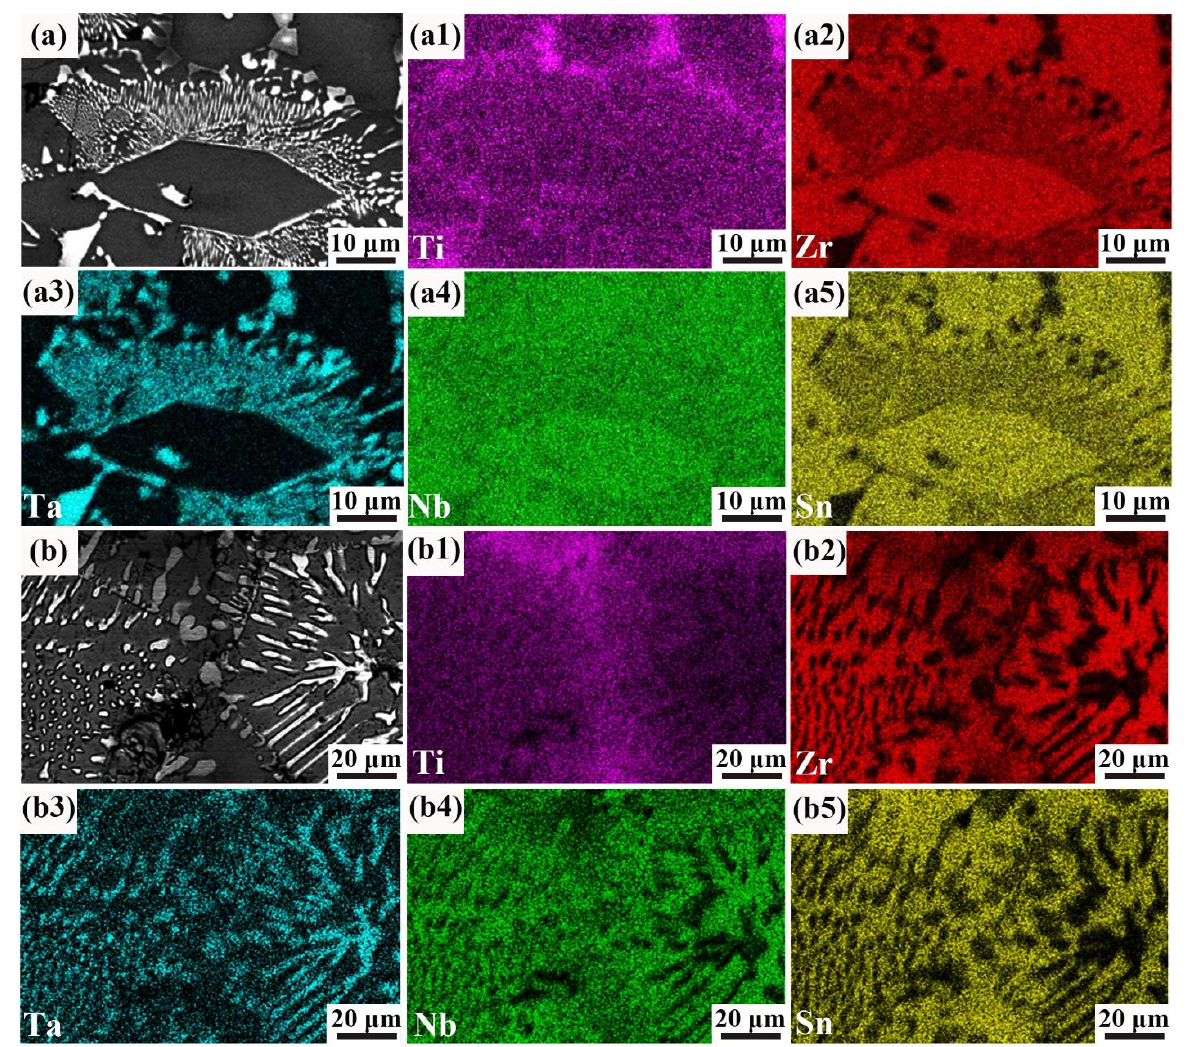
Figure 3. The map scanning of Sn30 BHEA and Sn35 BHEA: ( a )–( a5 ) Sn30 BHEA, ( b )–( b5 ) Sn35 BHEA.